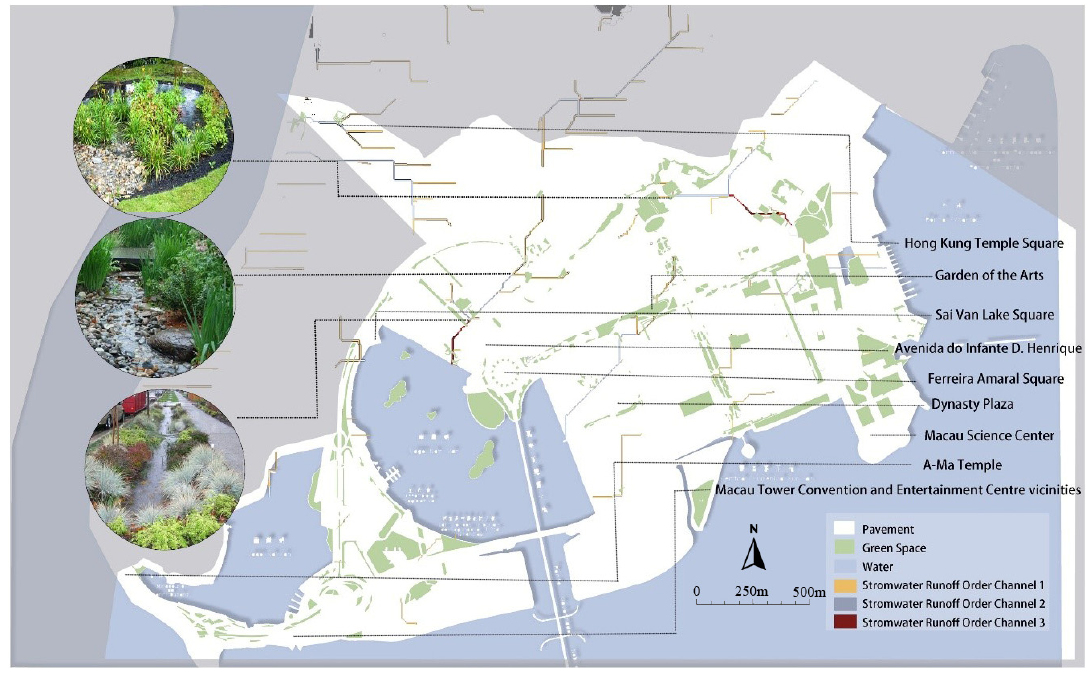
Figure 9. Low impact development (LID) technique proposal at storm water onsite runoff points and channels in Cathedral Parish.